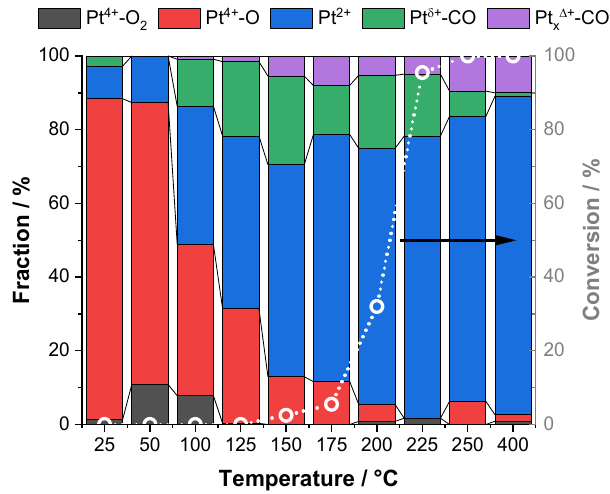
Figure 6. Fraction of the different Pt species at the middle of the catalyst bed, as determined by MCR-ALS and conversion of CO (empty circles connected via dotted line) as function of temperature in reaction mixture (1000 ppm CO, 10% O 2 in He).